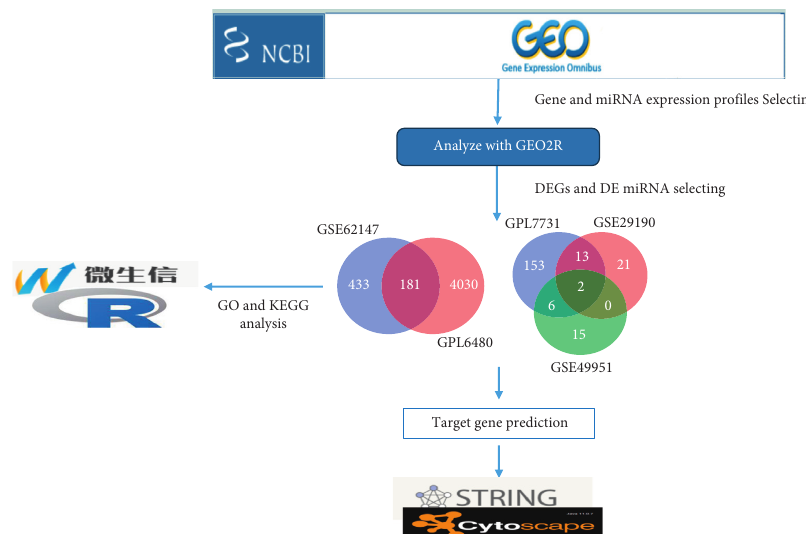
Figure 1: Flow diagram of bioinformatics